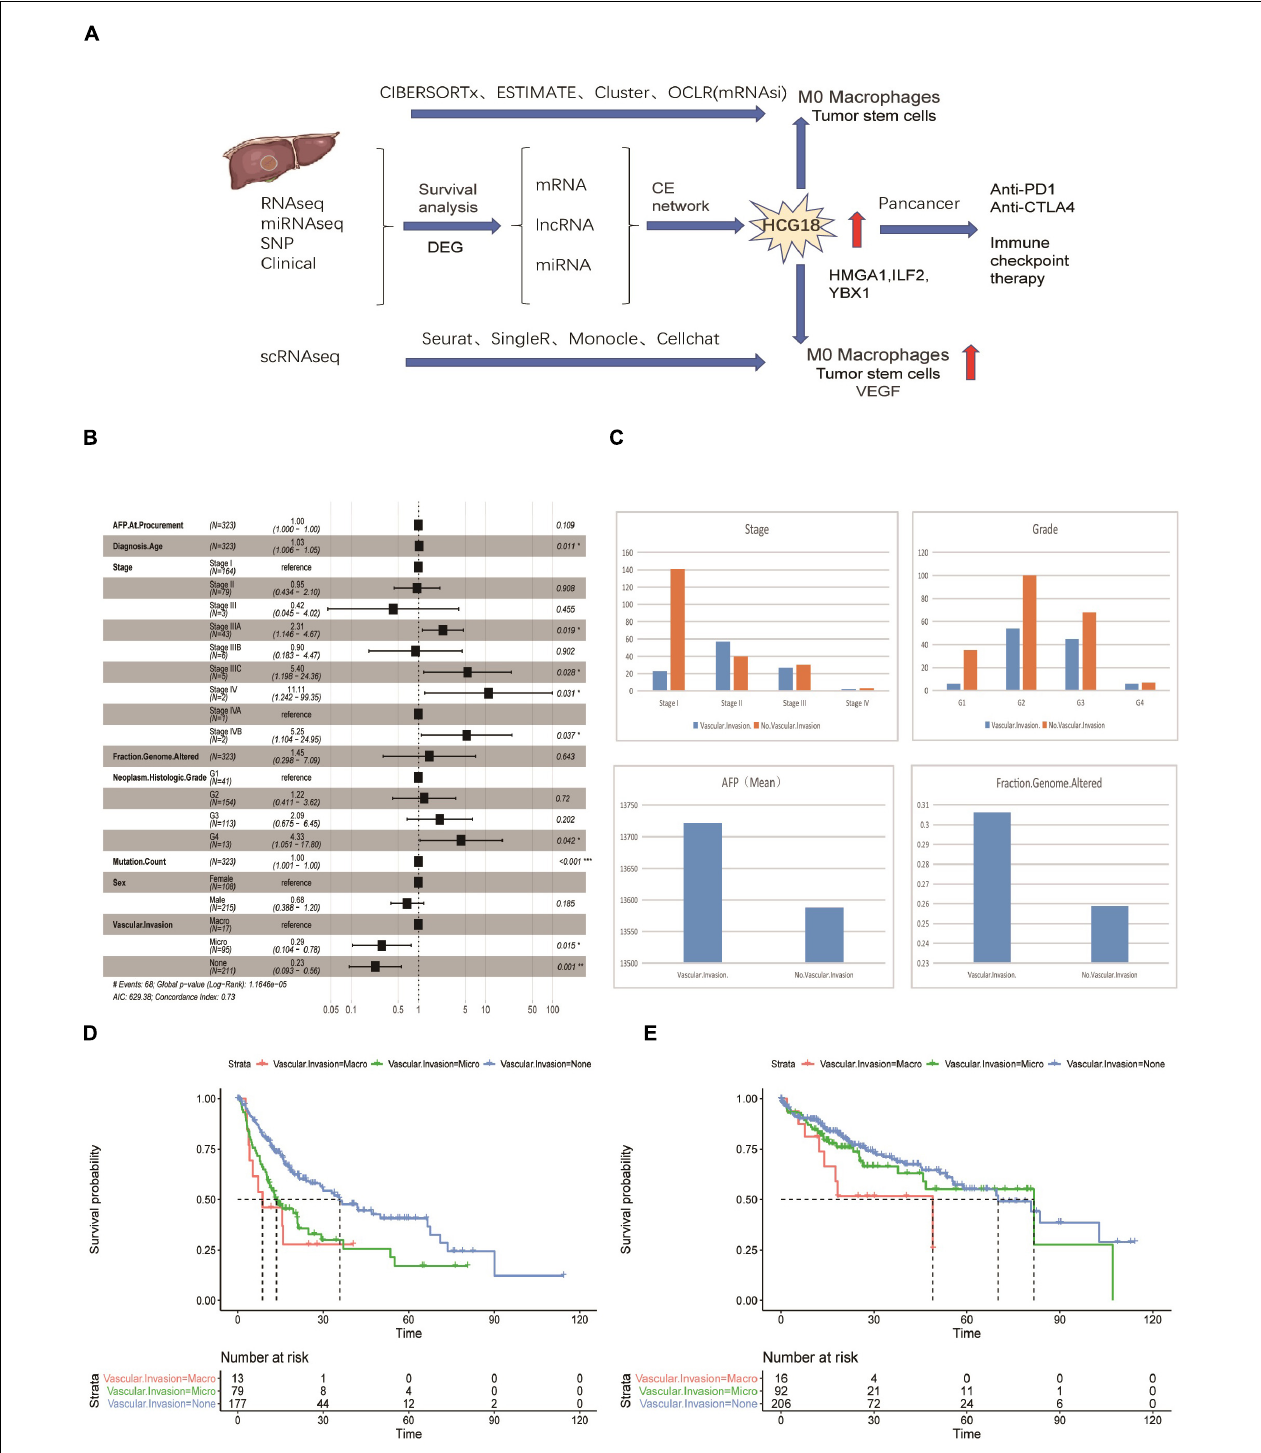
FIGURE 1 | Vascular invasion has independent prognostic significance in hepatocellular carcinoma. (A) Data flow chart for this study, including data types, algorithms, and part of the R package. (B) Forest map based on multi-factor Cox regression of clinical characteristics of TCGA samples. Compared with the reference value, relative risk less than 1 was considered to be protective, while relative risk greater than 1 was considered to be a risk factor. P < 0.05 was considered statistically significant. (C) Histogram of stratified frequency statistics of vascular invasion in staging and grading, histogram of vascular invasion, AFP and genomic changes. (D) Disease-free survival analysis based on vascular invasion stratification. (E) Overall survival analysis based on stratification of vascular invasion. * P < 0.05; ** P < 0.01; *** P < 0.001.